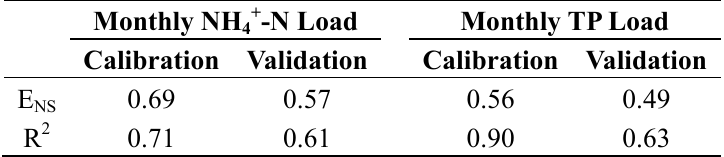
Table 4. Evaluation of monthly NH 4+ -N and TP